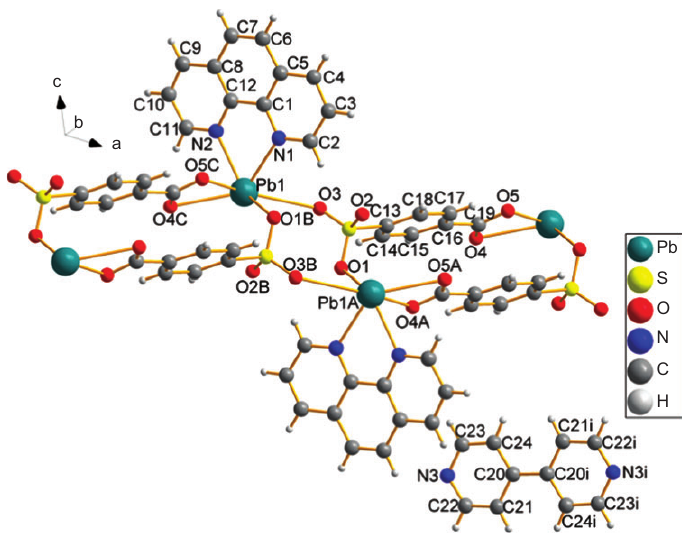
Figure 1 Coordination environment of the Pb atom with 4,4 ′ -bipy acting as a guest